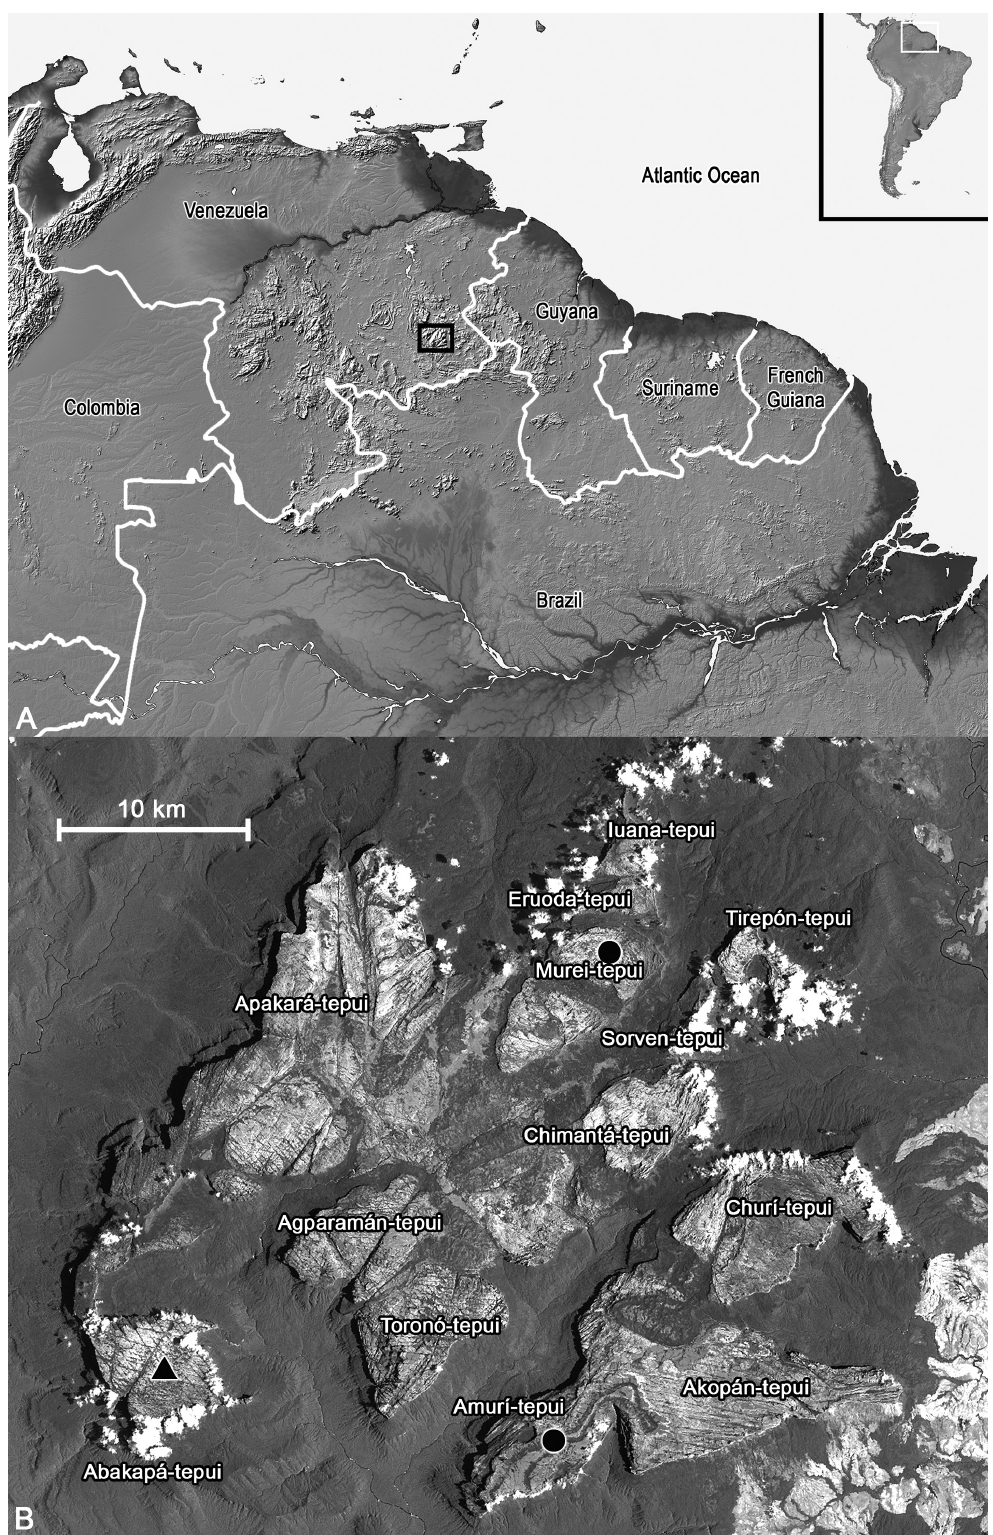
Fig. 8. Map of the Guiana Shield region ( A ), with enlarged black rectangle corresponding to the Chimantá Massif ( B ). Black triangle indicates type locality, black dots indicate other know localities for the